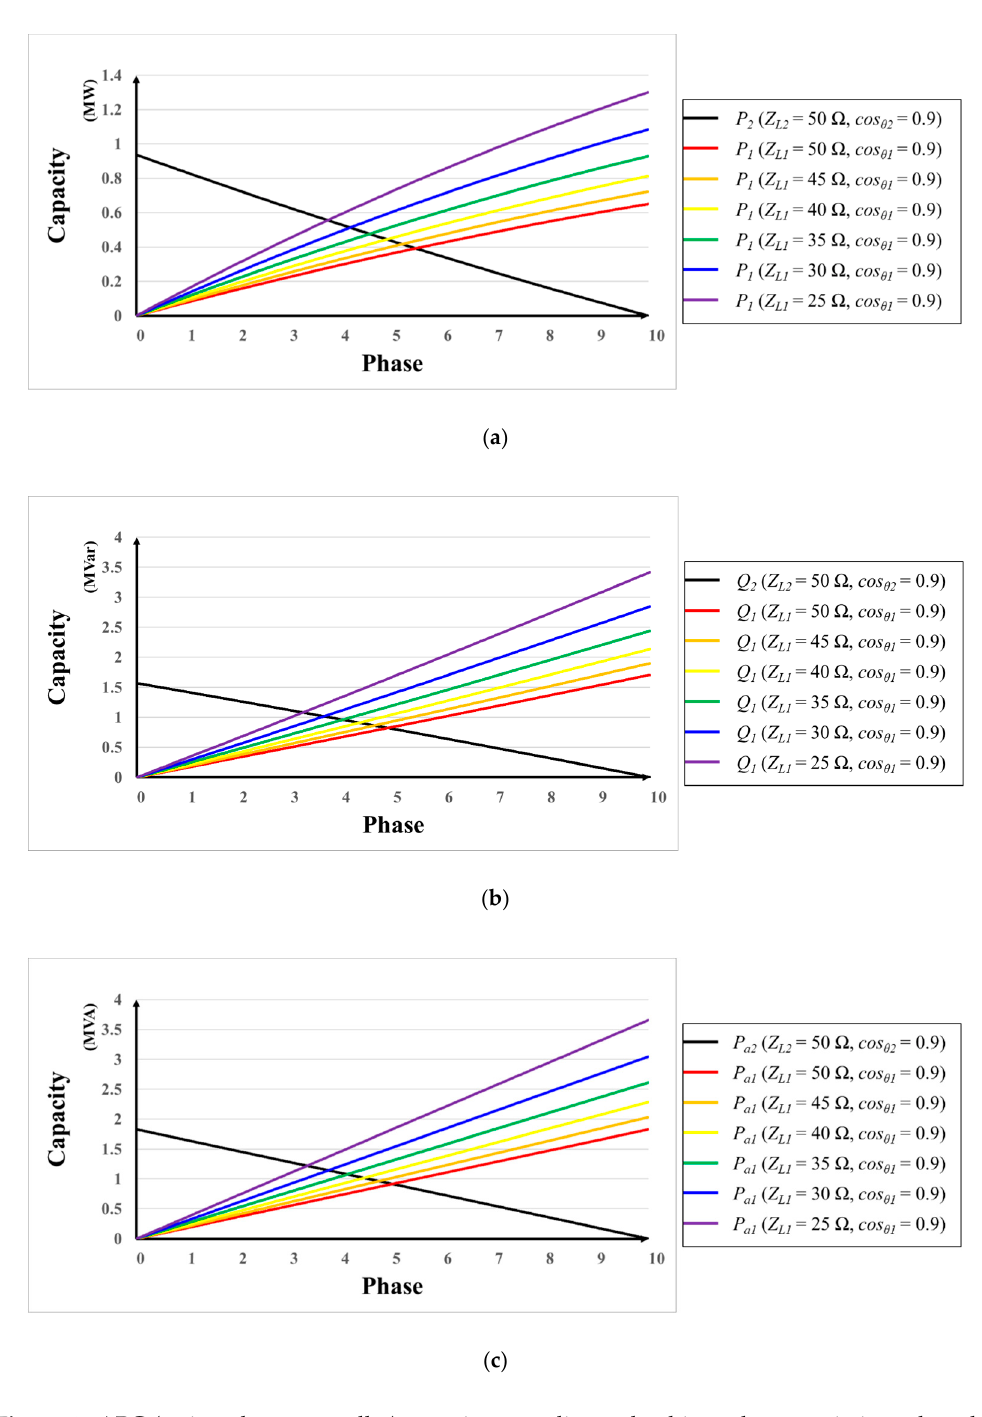
Figure 4. APC (active phase controller) capacity according to load impedance variation when the lagging power factor (PF = 0.9) is constant. ( a ) Active power; ( b ) reactive power; ( c ) apparent power.